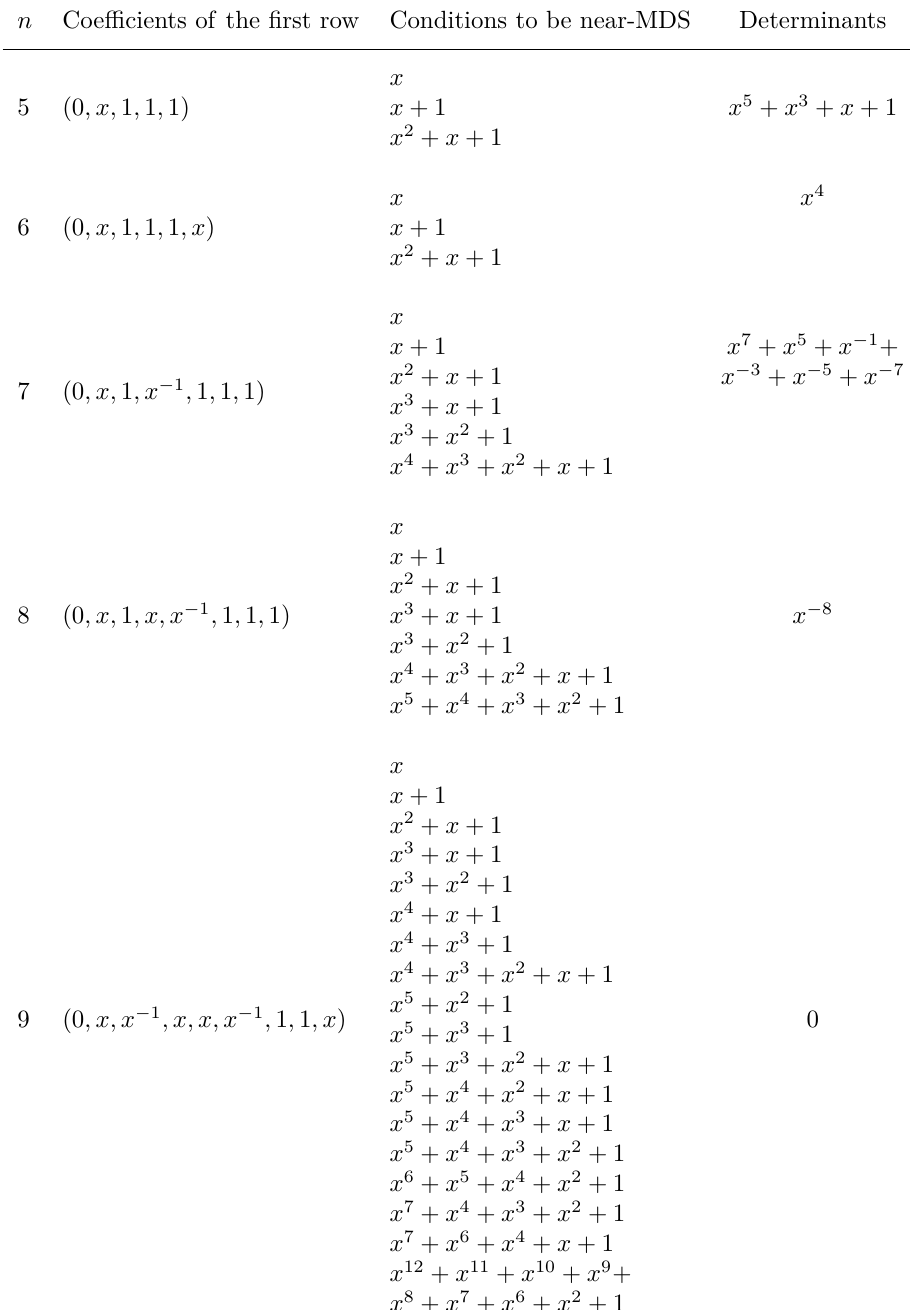
Table 2: Examples of generic near-MDS circulant matrices of order 5 ≤ n ≤ 9 n Coefficients of the first row Conditions to be near-MDS